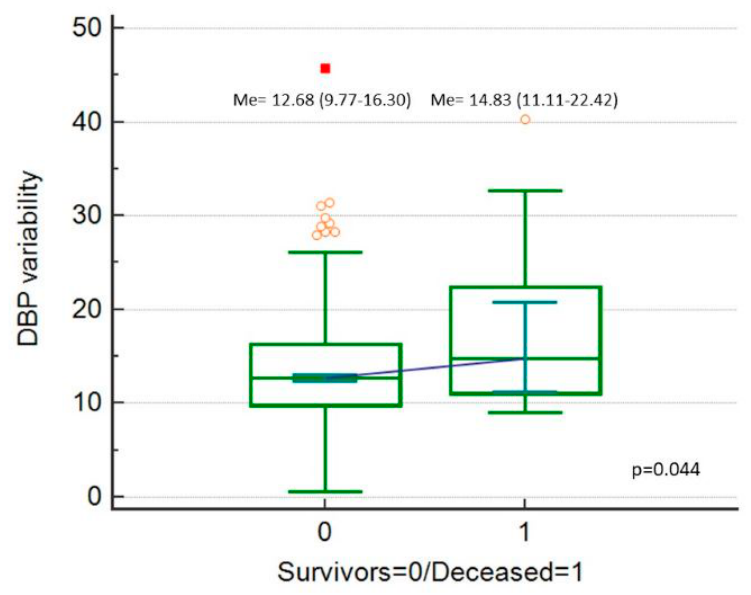
Figure 3. Diastolic blood pressure (DBP) variability (expressed as DBP_Cv in %), comparison between deceased patients and survivors.